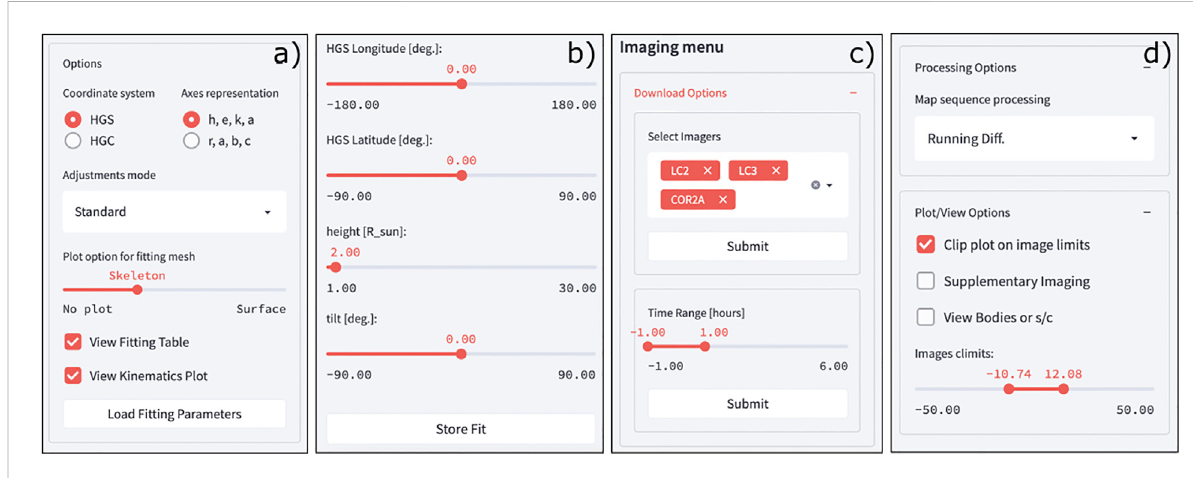
Figure 6B. Using a time slider, the different loaded images can be